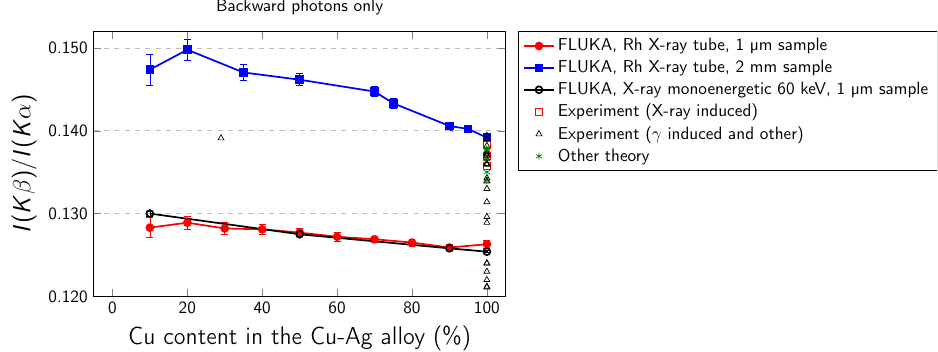
Figure 5. K β / K α intensity ratio arising from the primary X-ray simulated with FLUKA, calculated for backward output flux in 1 µm and 2 cm